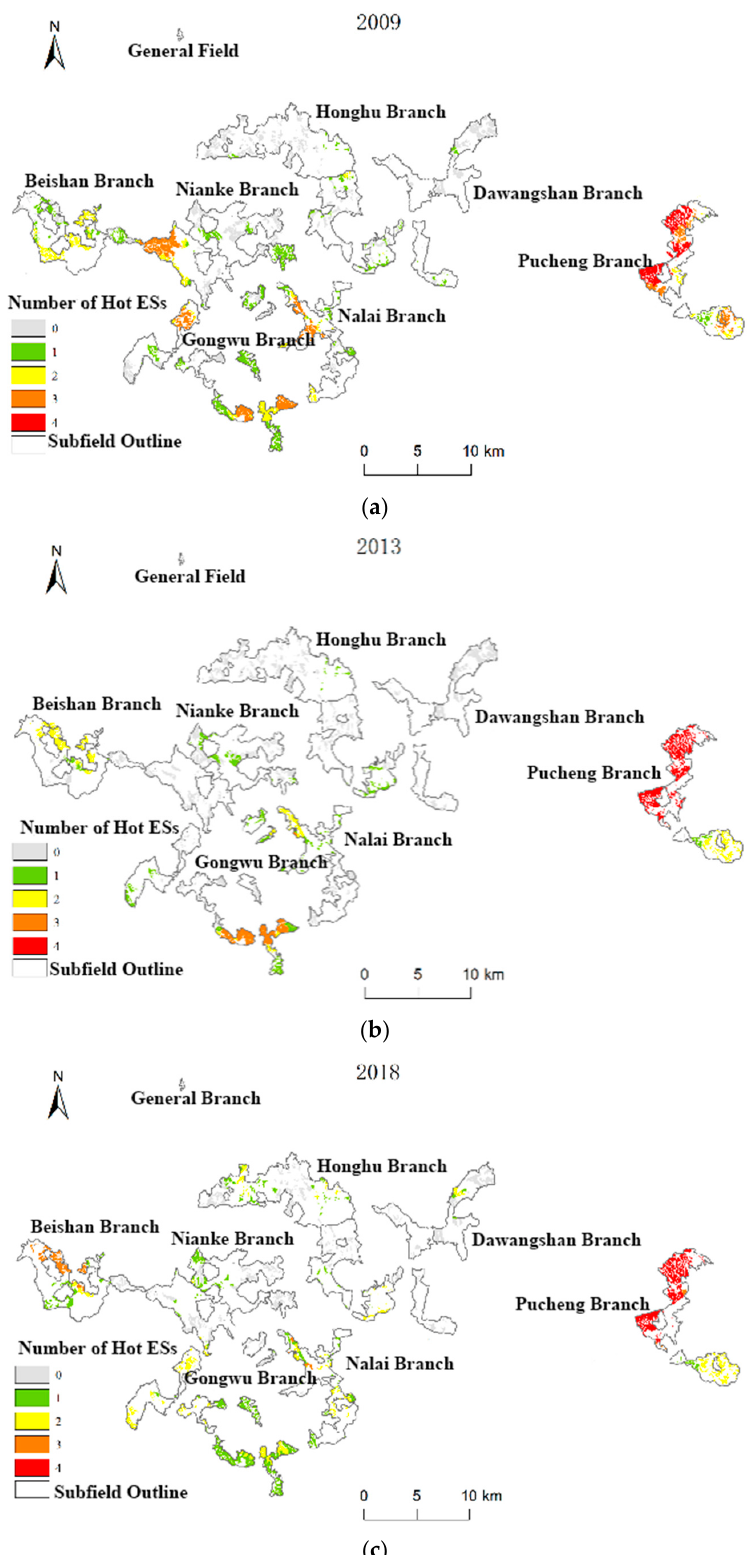
Figure 11. Number of hot spot ESs in PM plantations in Guangxi Paiyangshan Forest Farm from 2009 to 2018: ( a ) 2009; ( b ) 2013; ( c ) 2018.